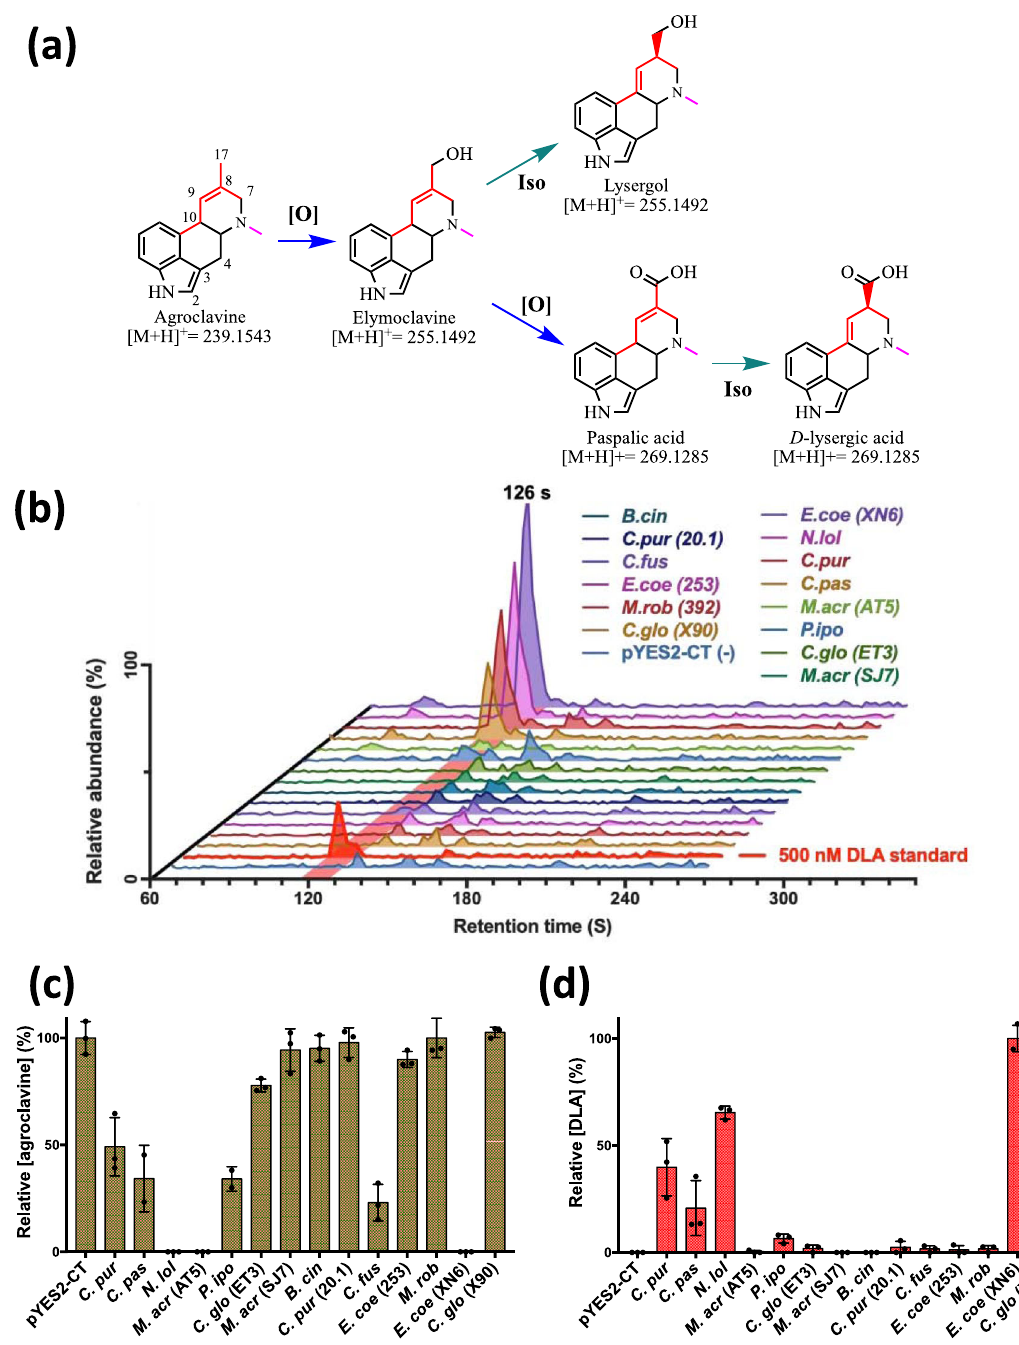
Fig. 4 Screening of CloA orthologues. a The putative oxidation and isomerization reactions catalyzed by CloA. b LC-MS/MS chromatograms of the products showing the ion transition of 269 → 223 m/z, produced by the CloA orthologs. Chromatograms appear in the order (bottom to top): pYES2-CT, DLA standard, C.glo (X90), M.rob (392), E.coe (253), C.fus , C.pur (20.1), B.cin, M.acr (SJ7), C.glo (ET3), P.ipo , M.acr (AT5), C.pas , C.pur , N.lol , E.coe (XN6). c Relative amounts of agroclavine consumed by the screened CloA orthologues. d Relative amounts of DLA produced by the various CloA orthologues. Data are presented as mean values + / − standard deviation. Error bars represent standard deviations calculated from three biological replicates. Source data are provided as a Source Data fi